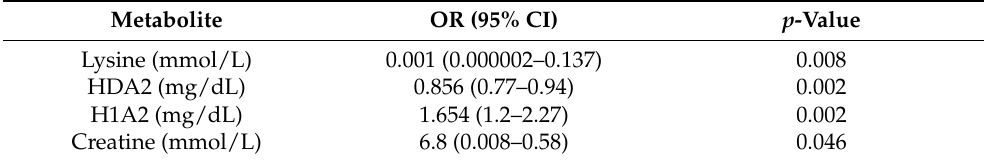
Table 6. Multivariate analysis of the metabolites independently associated with the presence of cirrhosis.